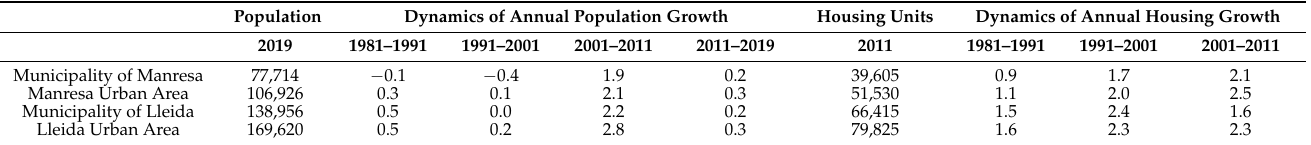
Table 1. The dynamics of population growth and housing in the municipalities and urban areas of Manresa and Lleida [39]. Population Dynamics of Annual Population